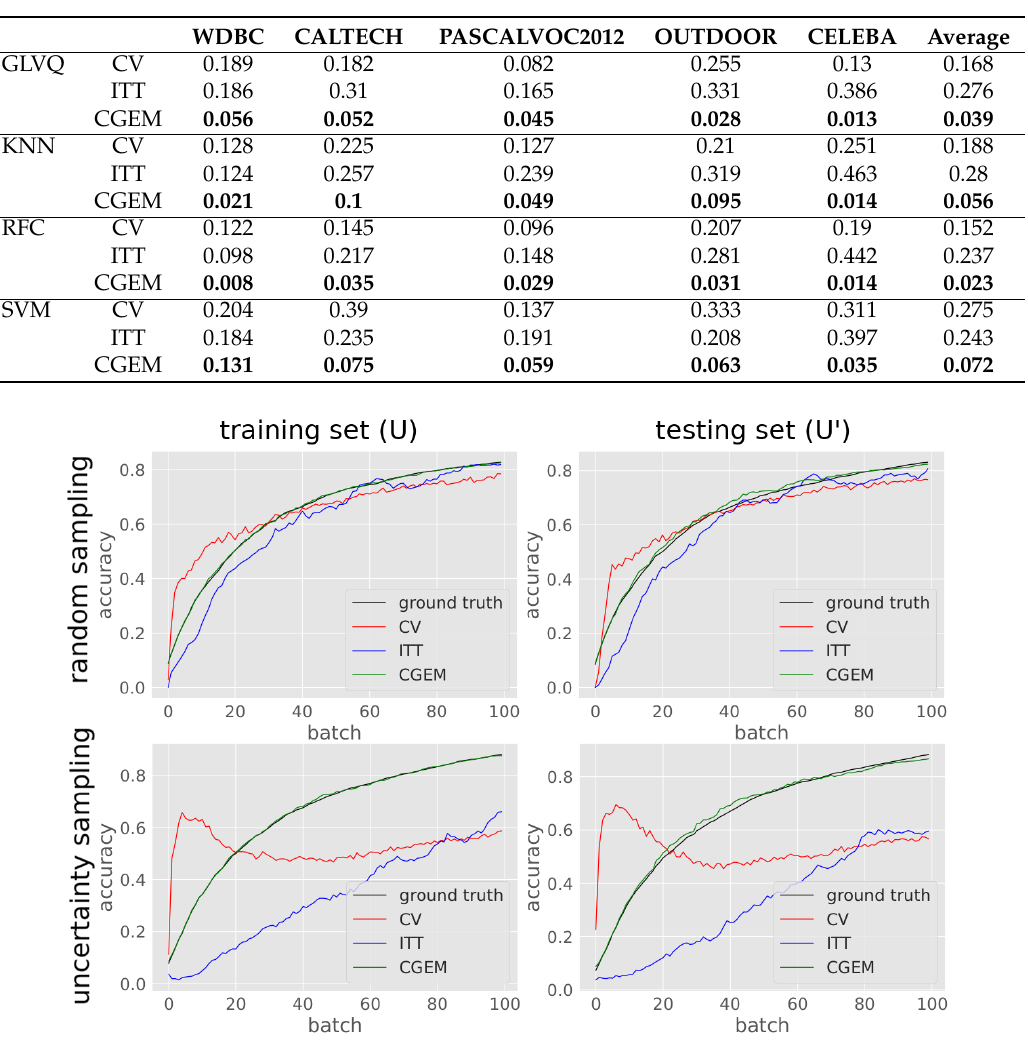
Table 6. Evaluation of accuracy estimation error (AEE) of CGEM approach compared to baseline models. The classifier was trained with incrementally using Active Learning with an uncertainty sampling querying strategy. Accuracy estimation was done after each batch. The table shows mean absolute error (MAE) compared to ground truth.